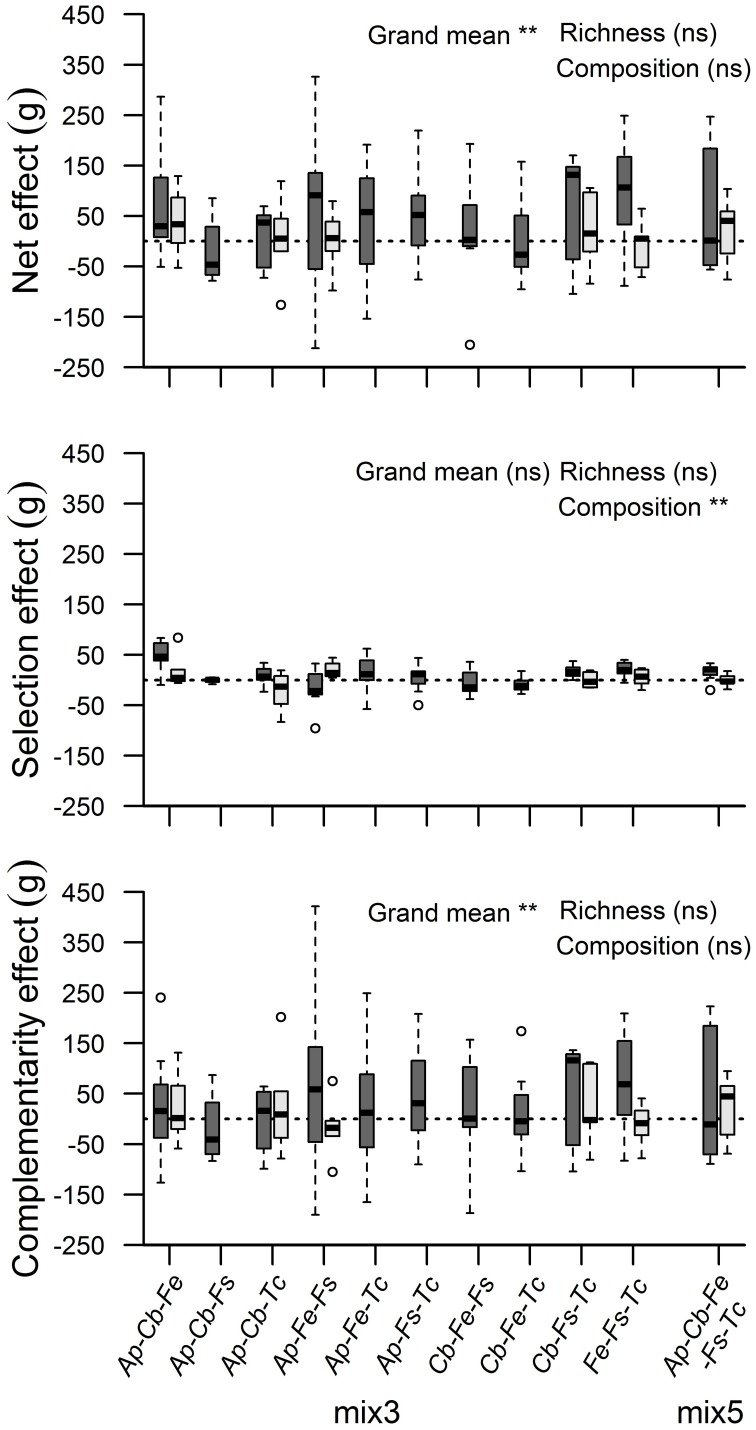
Additive partitioning of biodiversity effects on accumulated biomass of mixed tree assemblages: Net diversity effect, selection effect, and complementarity effect in their dependence on species richness (three vs. five species) and species composition. Asterisks indicate significant effects for the moist treatment (dark boxes; **p < 0.01; ns, non-significant). In the dry treatment, no significant effects were detected (bright boxes). Circles above and below boxplots show outlier values.